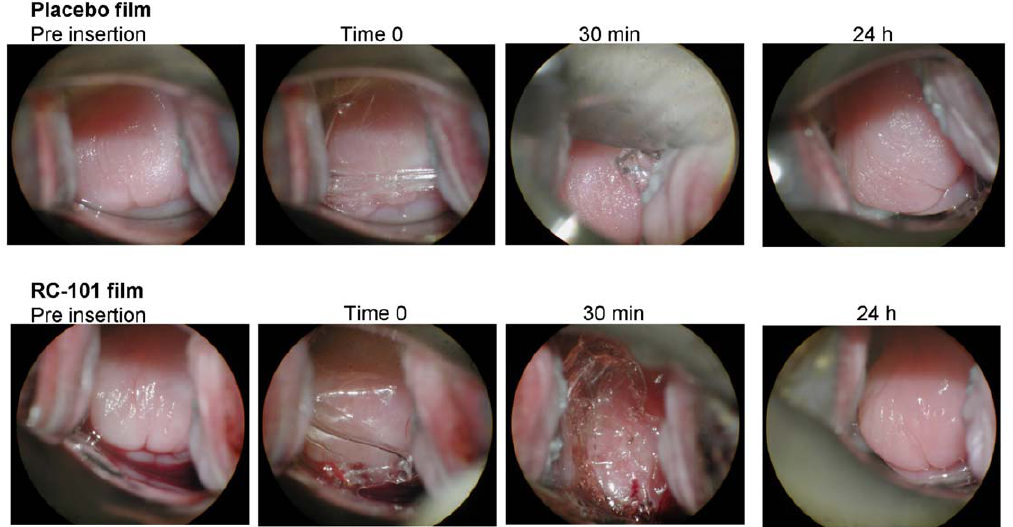
Figure 3. Colposcopy of the cervicovagina reveals no adverse effects of RC-101 films. Images from colposcopic examination of cervicovaginal mucosa of a representative pigtailed macaque obtained prior to film insertion, at the time of insertion (Time 0), and 30 min and 24 hr after film insertion. Note the absence of mucosal aberrations at all time points with either RC-101 films or placebo films.